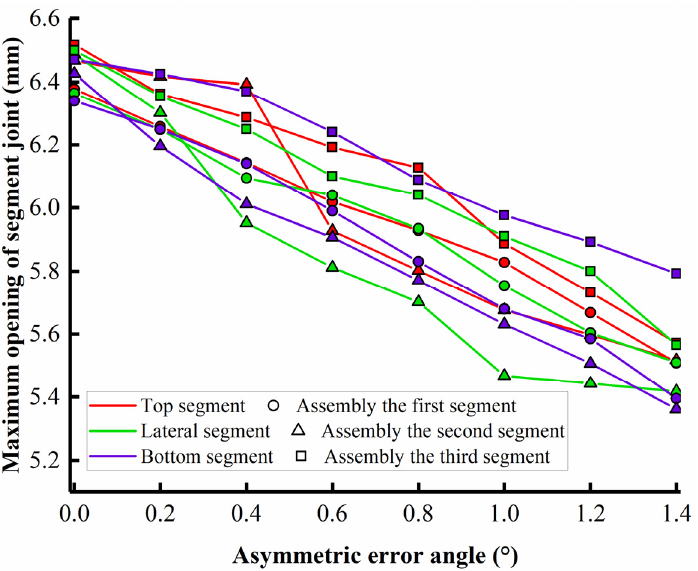
Figure 18. Maximum opening of segment joint in the presence of outward deflection.